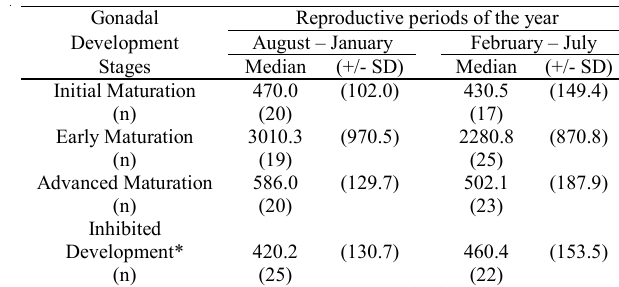
Table 5. Mean concentration (pg/ml) and standard deviation (+/ - SD) of total testosterone in non-infested males of Cyphocharax gilbert in different gonadal development stages and infested males (*) fromrio Itabapoana from August, 1997 to July, 2000.